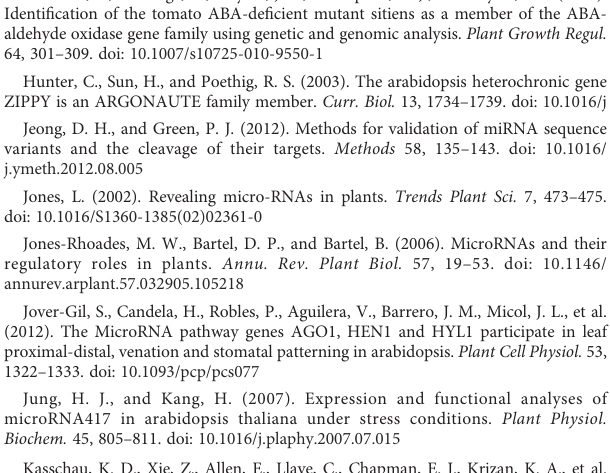
Comparison of miRbase.